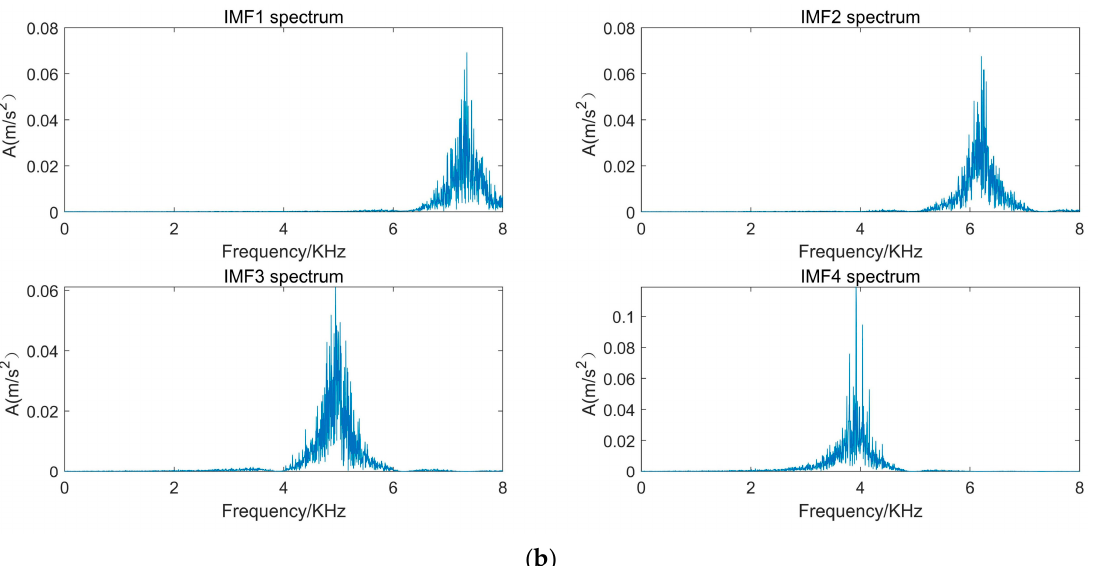
Figure 5. Decomposition result of VMD for the simulated signal. ( a ) Time domain decomposition result; ( b ) Frequency domain decomposition result.